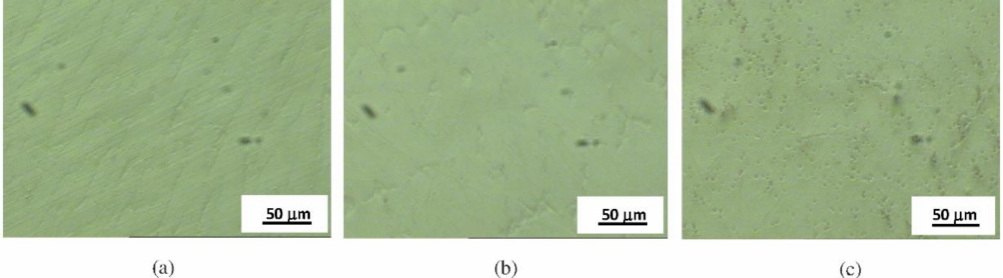
Figure 2. Microstructures after electrochemical treatment for ( a ) specimen Ni3, ( b ) specimen Ni1, and ( c ) specimen